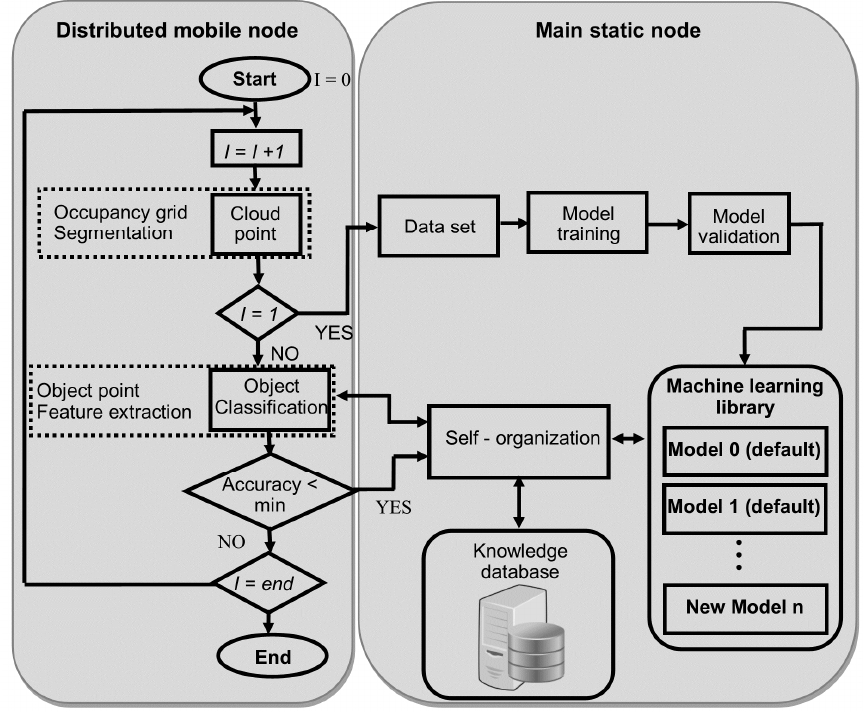
Figure 4. Block diagram of classification methodology procedure for object-type identification.